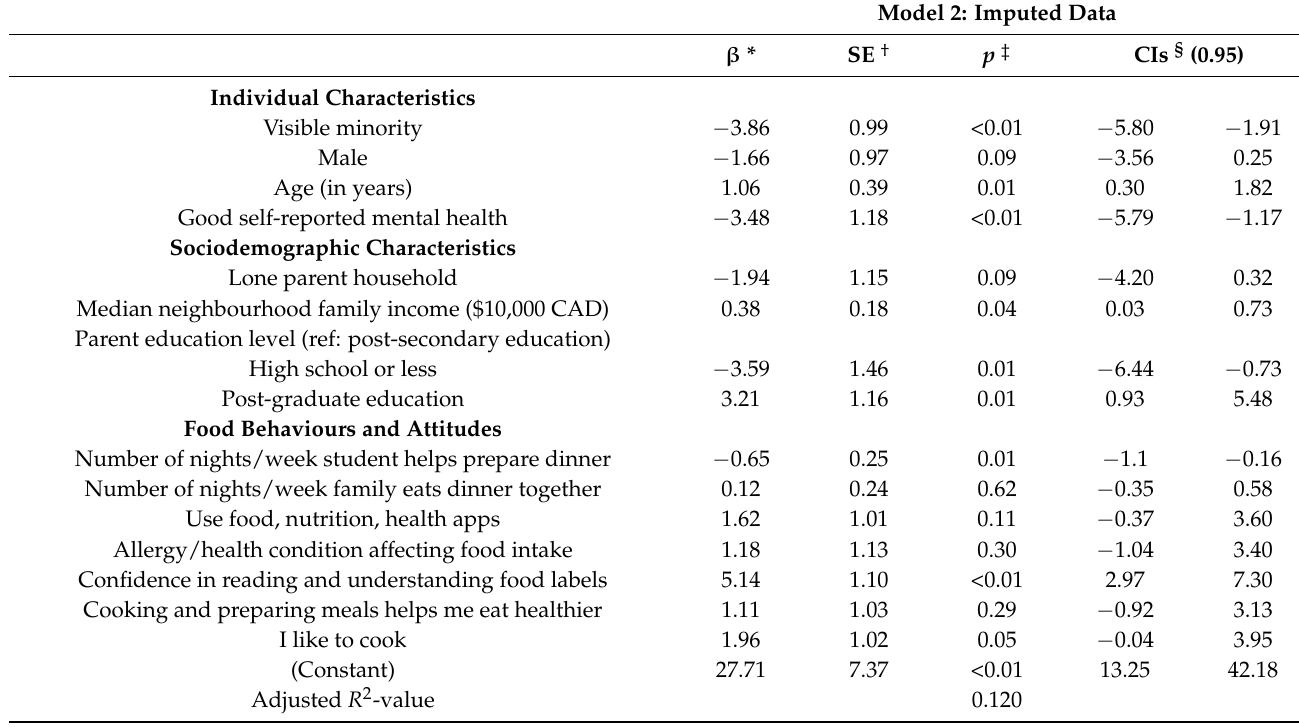
Table 5. Multiple Linear Regression for Nutrition Knowledge Score (N = 968).